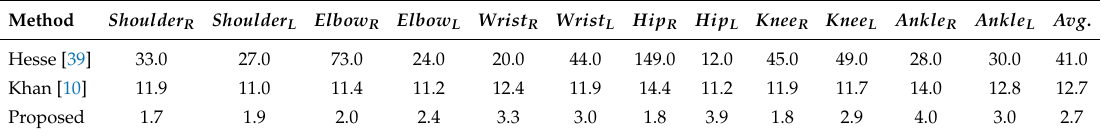
Table 1. Average joint position error (in millimeter) for each body part. The subscripts R and L represents the right and the left body part, respectively.